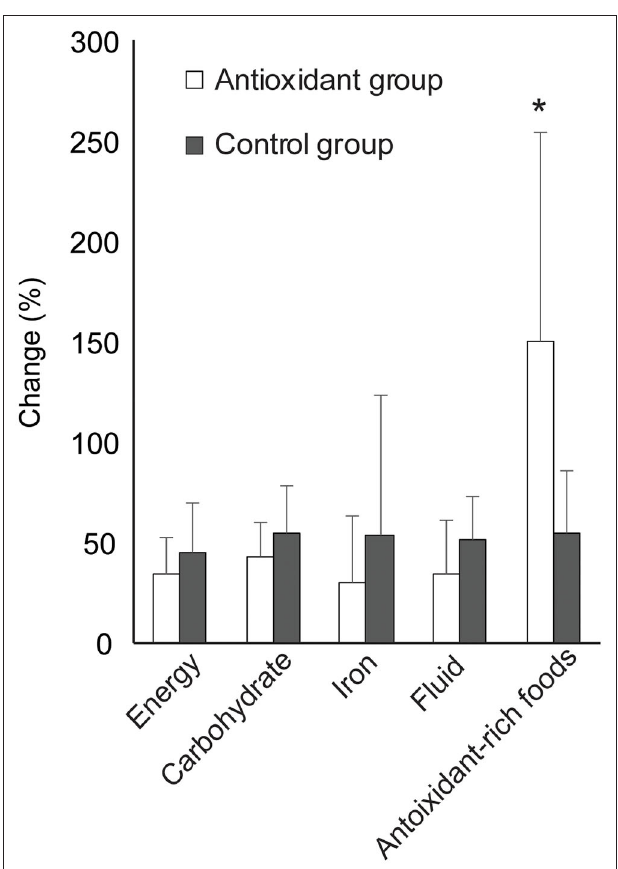
FIGURE 3 | Relative change in the mean daily intake of principal nutrients for athletes training at altitude; energy, carbohydrate, iron, fluid, and antioxidant-rich foods in the antioxidant ( n = 16) and control group ( n = 15). Presented as mean altitude-sea level intra-individual change (%) and standard deviation. *indicates significant difference, p < 0.05. P -value is obtained from paired t